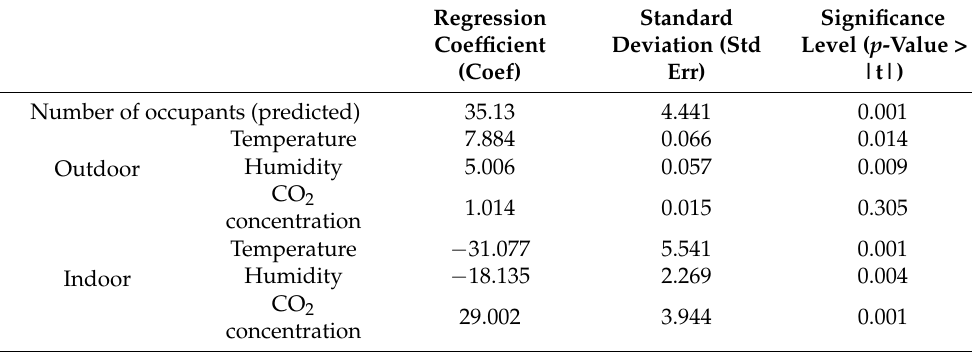
Table 7. Significance test for the energy consumption prediction